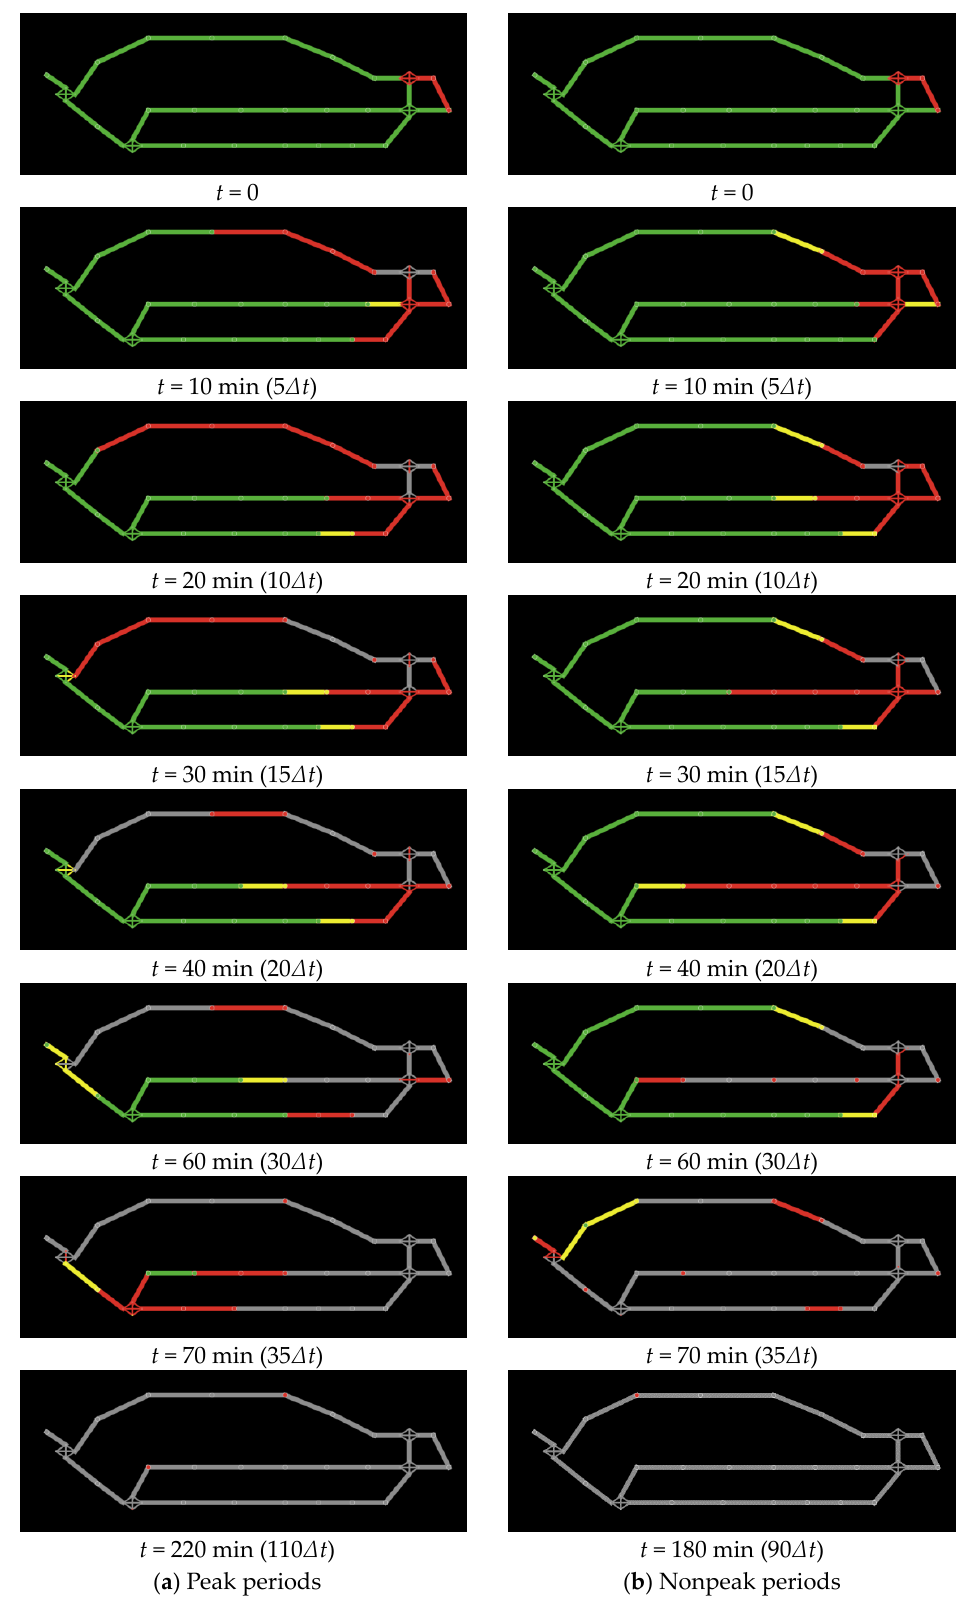
Figure 13. Congestion propagation process in